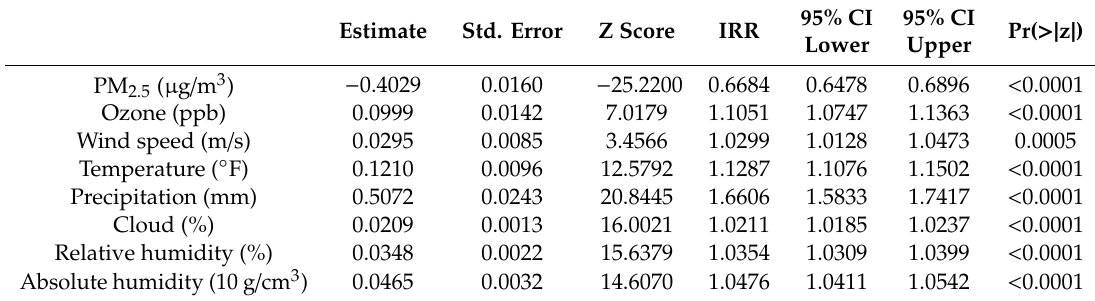
Table 3. Single-predictor regression model results for the relation among the moving average of lag 0–21 days of each environmental predictors and new COVID-19 cases adjusted by trend and lag 1-day values of cases.